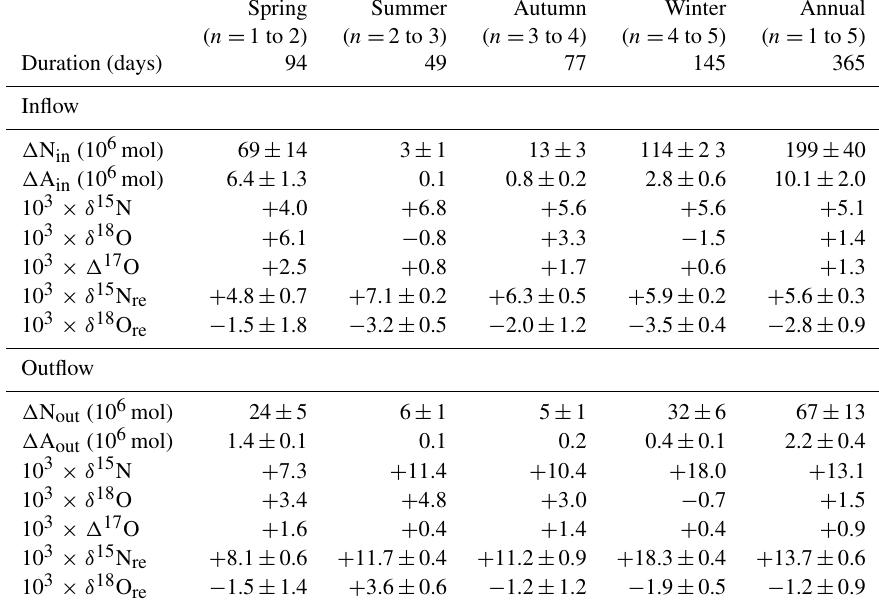
Table 2. Estimated gross influx/efflux of total nitrate ( (cid:49) N) and atmospheric nitrate ( (cid:49) A) via inflows/outflows during each observation interval, together with the average δ 15 N, δ 18 O, and (cid:49) 17 O values of total nitrate and remineralised portions of nitrate ( δ 15 N re and δ 18 O re ) in the inflows/outflows during each interval.